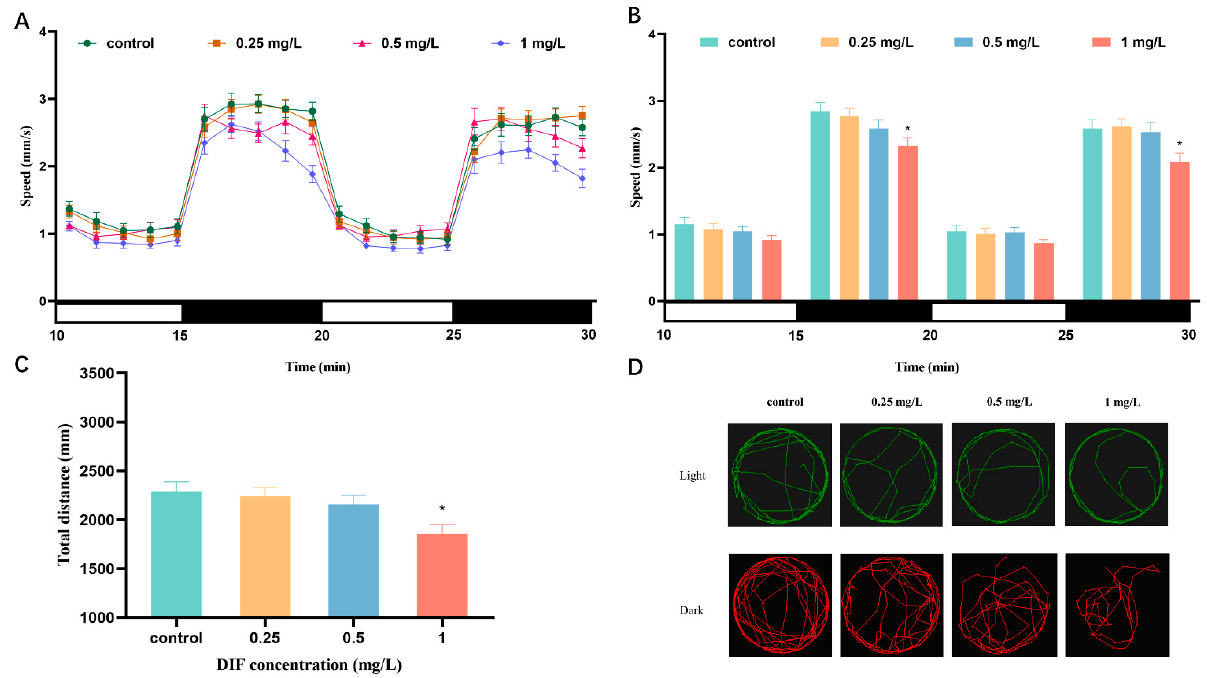
Figure 3. The locomotor behavior of zebrafish larvae after difenoconazole exposure (0, 0.25, 0.5, and 1 mg/L) under light–dark photoperiod stimulation test at 120 hpf. ( A ) Locomotor patterns in response to light–dark change, ( B ) the average swimming speed, ( C ) the total distance of zebrafish larvae under light-dark cycle, and ( D ) representative locomotion tracking under light and dark conditions. Values are expressed as mean ± SEM of 3 replicates (8 larvae/replicate). * p < 0.05 indicates significant differences between exposure groups and the control group.